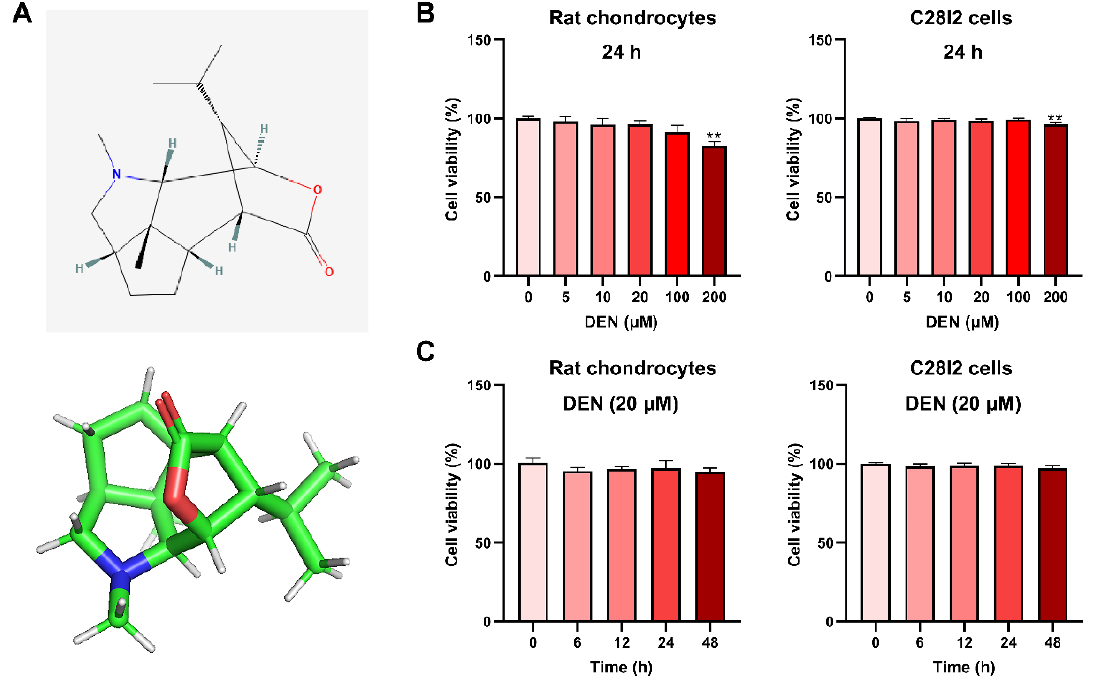
Figure 1. Cytotoxic effects of dendrobine (DEN) on the chondrocytes. ( A ) Chemical structure of DEN. ( B ) The cytotoxic effect of DEN on rat chondrocytes and C28I2 cells was determined at different concentrations (0, 5, 10, 20, 100, and 200 mM) for 24 h using a CCK8 kit. ( C ) The cytotoxic effect of 20 mM DEN on rat chondrocytes and C28I2 cells was determined during 48 h using a CCK8 kit. The data were expressed as mean ± SD of three repeated experiments. ** p < 0.01, n = 8.